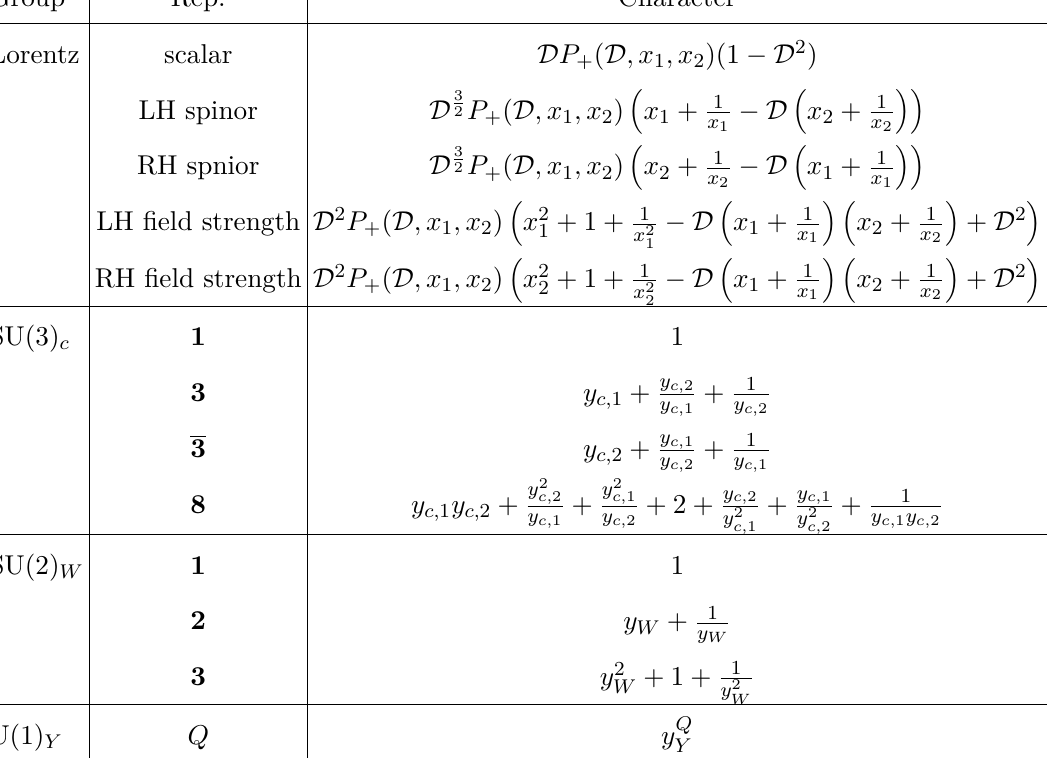
Table 4 . List of characters used to calculate the Hilbert series. We use parameters of maximal tori x 1 and x 2 for SU(2) l and SU(2) r respectively, ( y c, 1 , y c, 2 ) for SU(3) c , y W for SU(2) W , and y Y for U(1) . The spurion D represents the covariant derivative. P Y